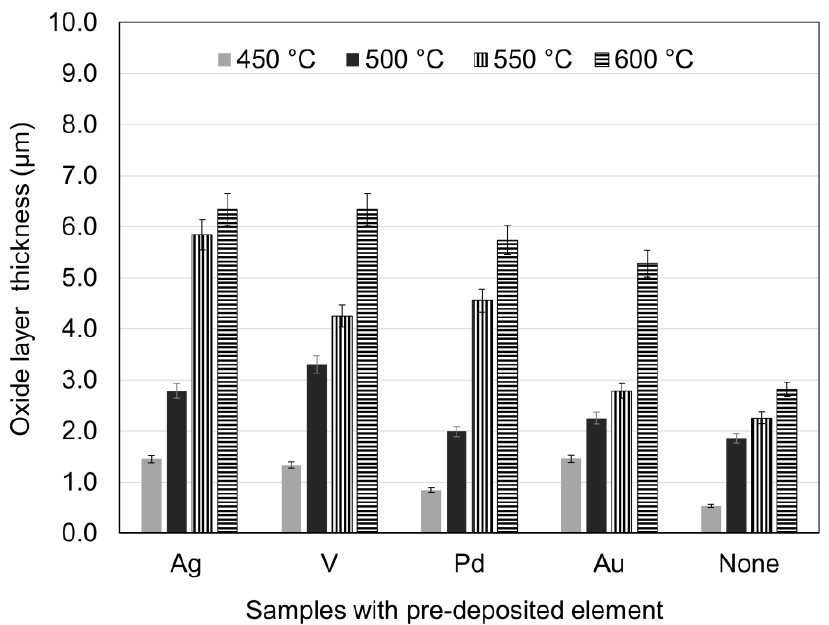
Figure 1. Surface oxide layer thickness of C2T 10 h processed samples with and without pre-depos- ited metal elements at different